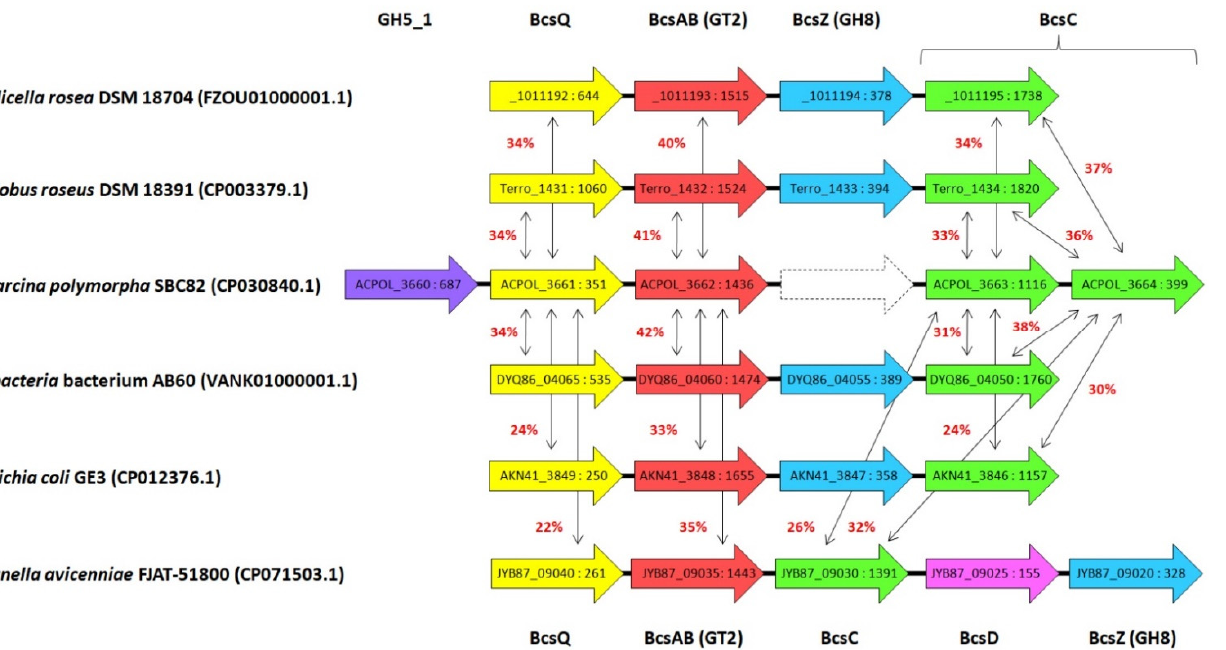
Figure 6. Structure of Acidisarcina polymorpha SBC82 T cellulose synthase locus and examples of similar loci in other organisms. Strains and the corresponding GenBank accession numbers are shown in the left column. Colored arrows correspond to ORFs, their locus tags and lengths are indicated inside. In the case of Granulicella rosea DSM 18704 only the second parts of the locus tags are indicated (SAMN05421770_1011192–SAMN05421770_1011195). The orthologous proteins are indicated by the same color. Names of encoded proteins are indicated in the first and last lines. Red numbers near double-sided thin arrows show the pairwise sequence identity of the A. polymorpha proteins and their orthologs. The dotted line is used to indicate the deleted bcsZ gene in the A. polymorpha SBC82 T